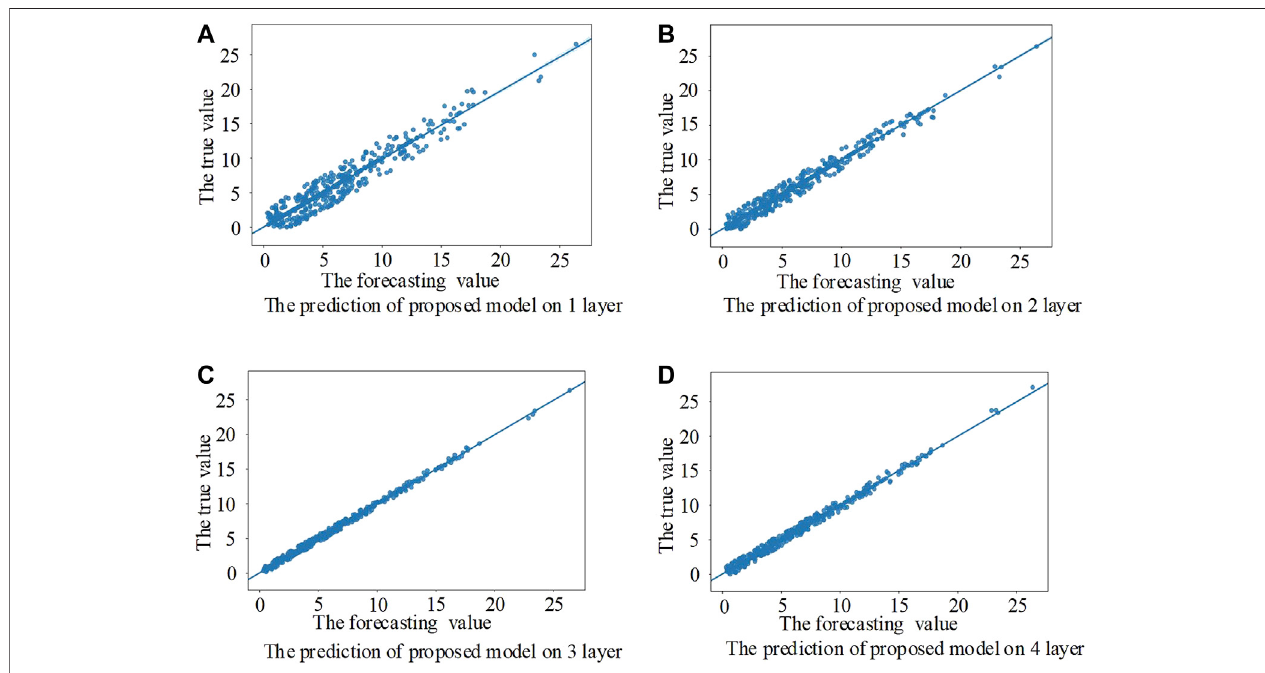
FIGURE 8 | Prediction scatter diagram of the different convolutional layer structures of the model in this paper.